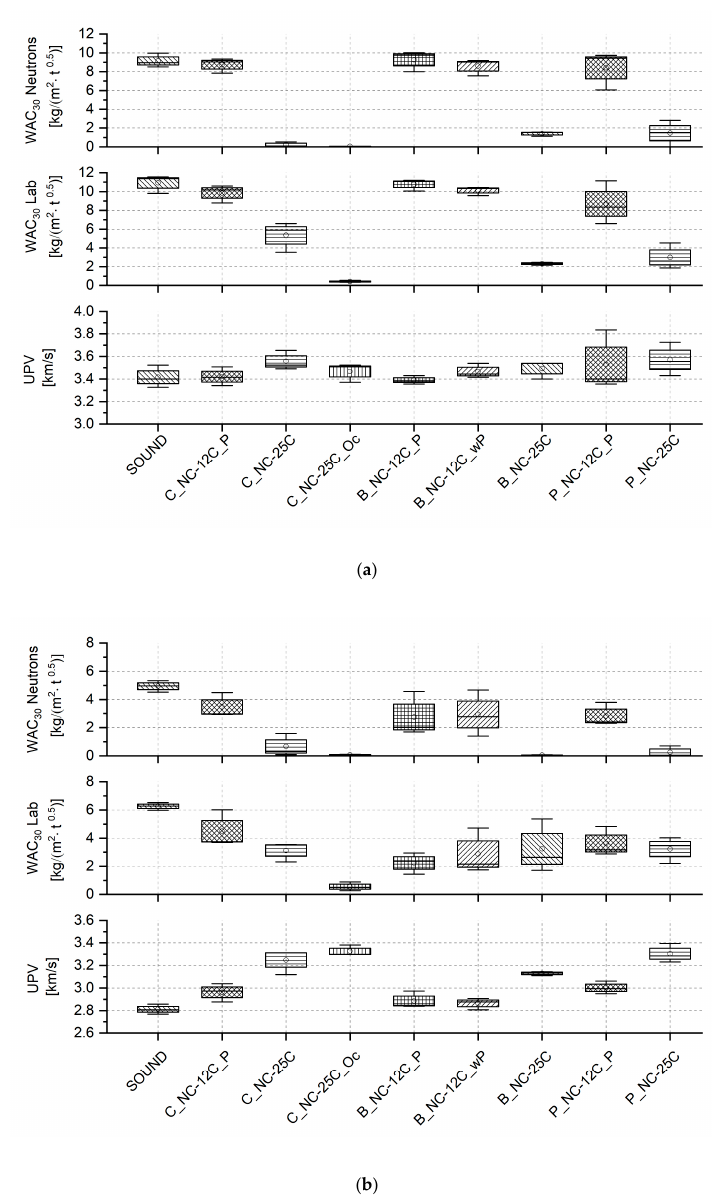
Figure 10. Comparative graph displaying water absorption coefficients reported as [kg/(m 2 · t 0.5 )] after 30 min for ( a ) St. Margarethen Limestone and ( b ) Schlaitdorf Sandstone, calculated from ( top ) neutron radiography and ( middle ) gravimetrically determined laboratory studies, and compared to values of ( bottom ) ultrasonic pulse velocity reported in [km/s]. Corresponding numerical values of the graphical representation can be extracted from Supplementary Materials, Table S2. Moreover, all water absorption curves extracted from neutron radiographs can be seen in Supplementary Materials, Figure S3 (St. Margarethen Limestone) and Figure S4 (Schlaitdorf